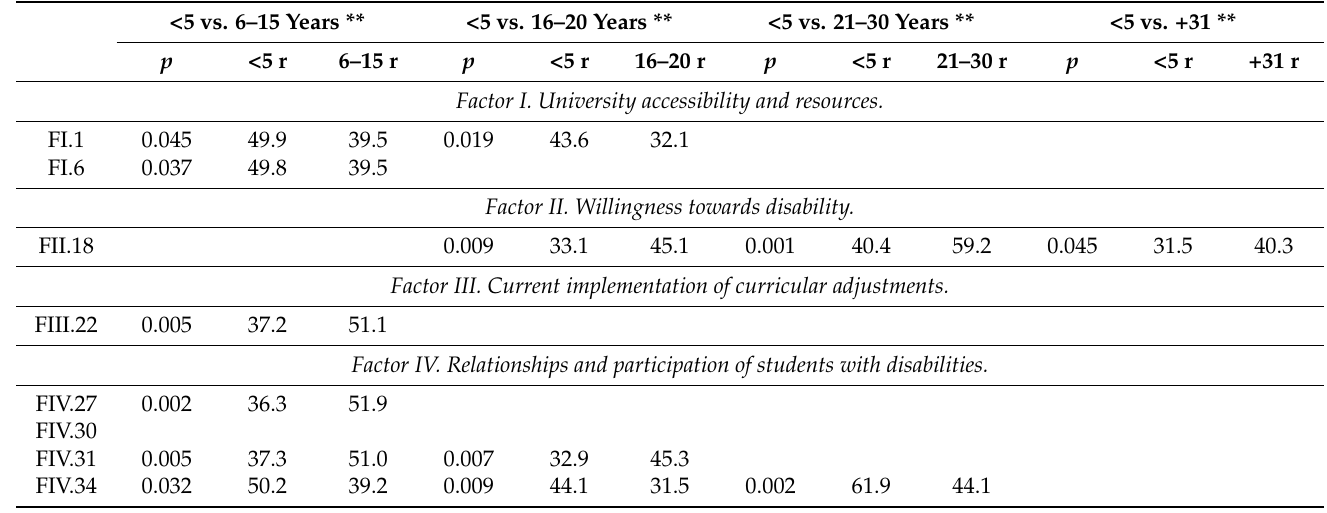
Table 10. Post hoc Kruskal–Wallis analysis by sections of teaching seniority.